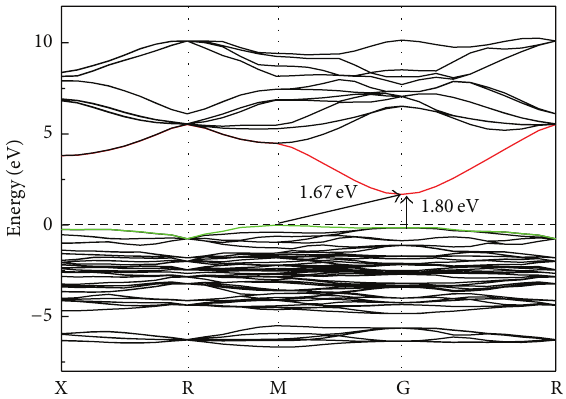
Figure 2: Band structure of Ag 3 AsO 4 calculated using the PBE0